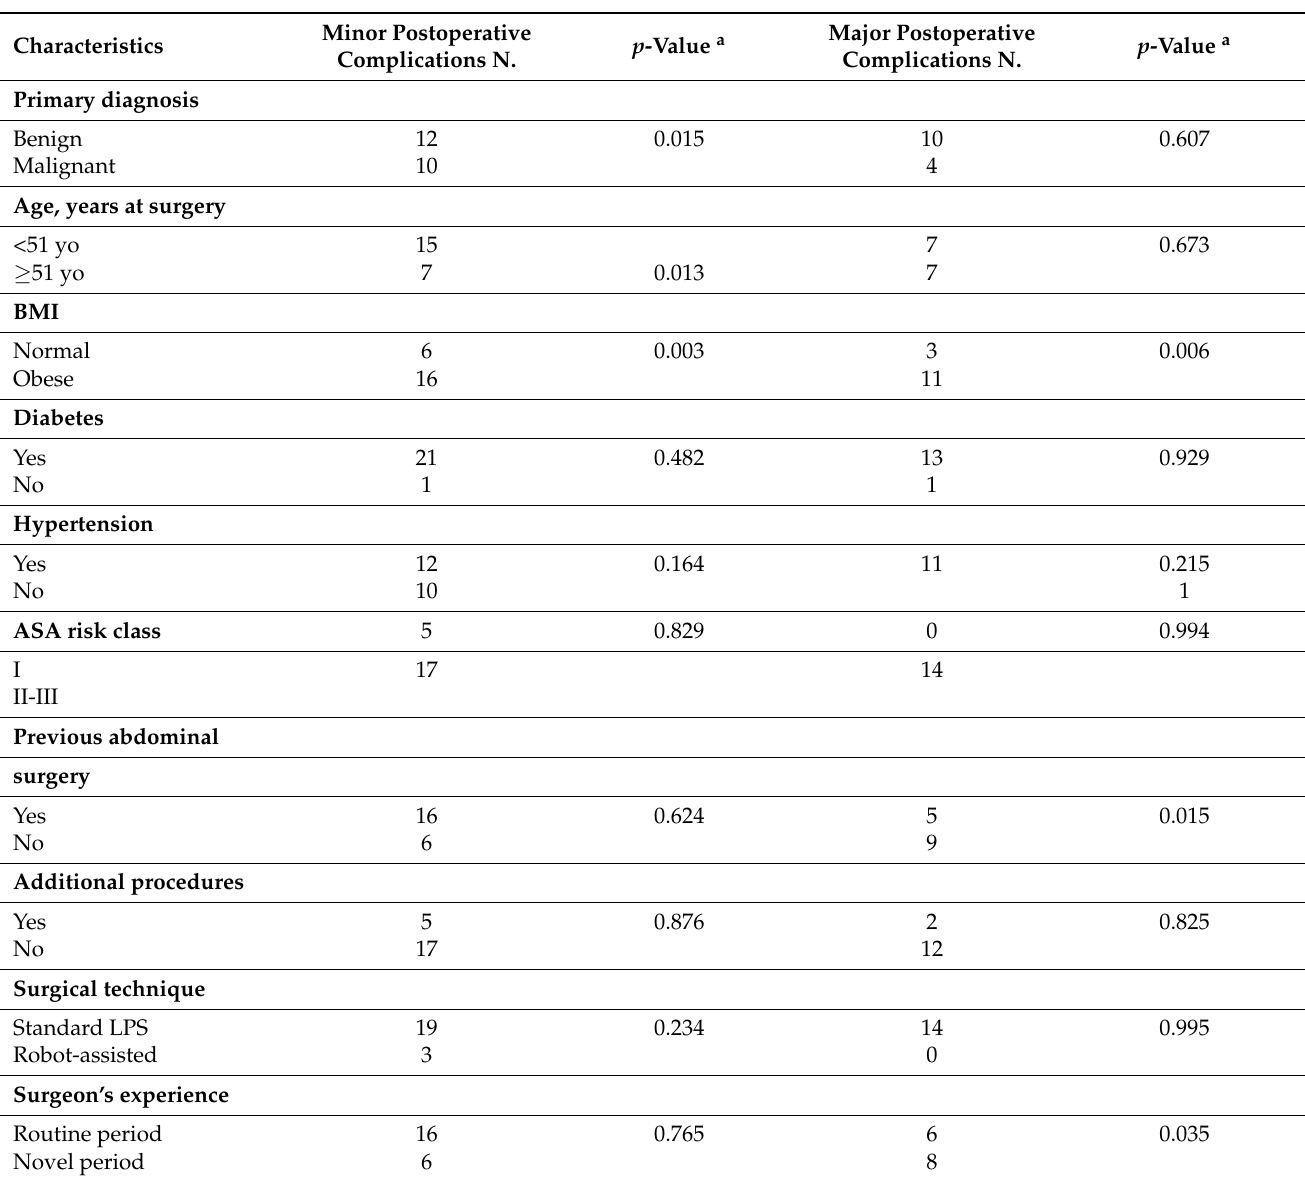
Table 4. Univariate analysis of postoperative complications based on clinical-pathological